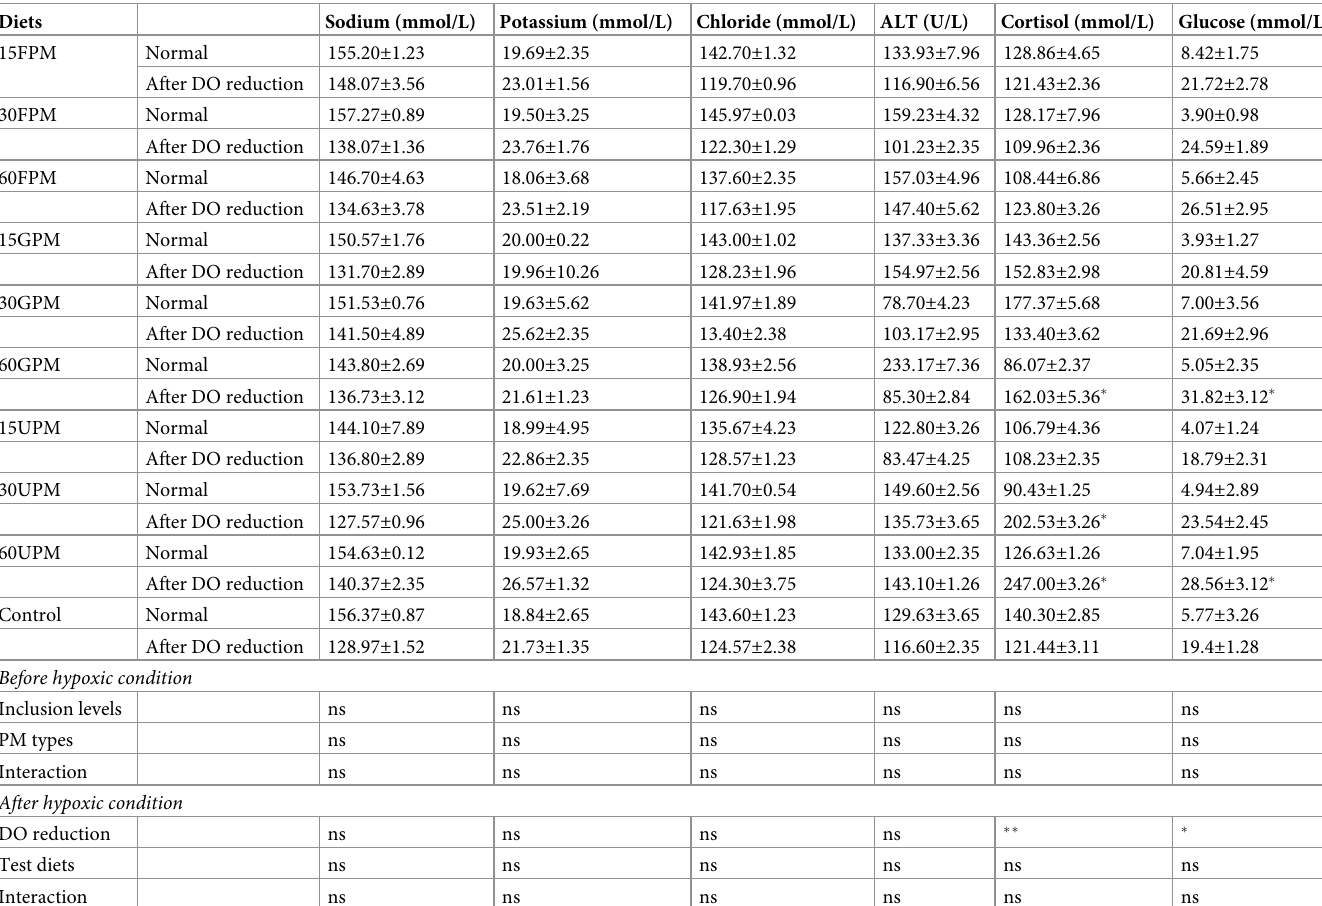
Table 5. Concentration of plasma sodium, potassium, chloride, ALT, cortisol and glucose of juvenile barramundi subjected to oxygen reduction shock (from 5.60 mg/L -1 to 2.00 mg/L -1 ) for 4